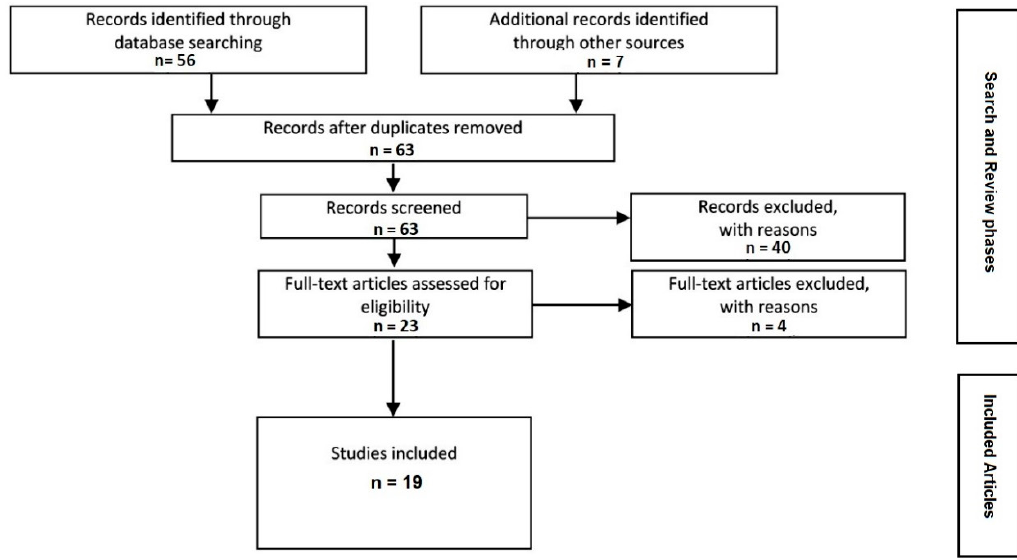
Figure 1. Results of the scoping review.